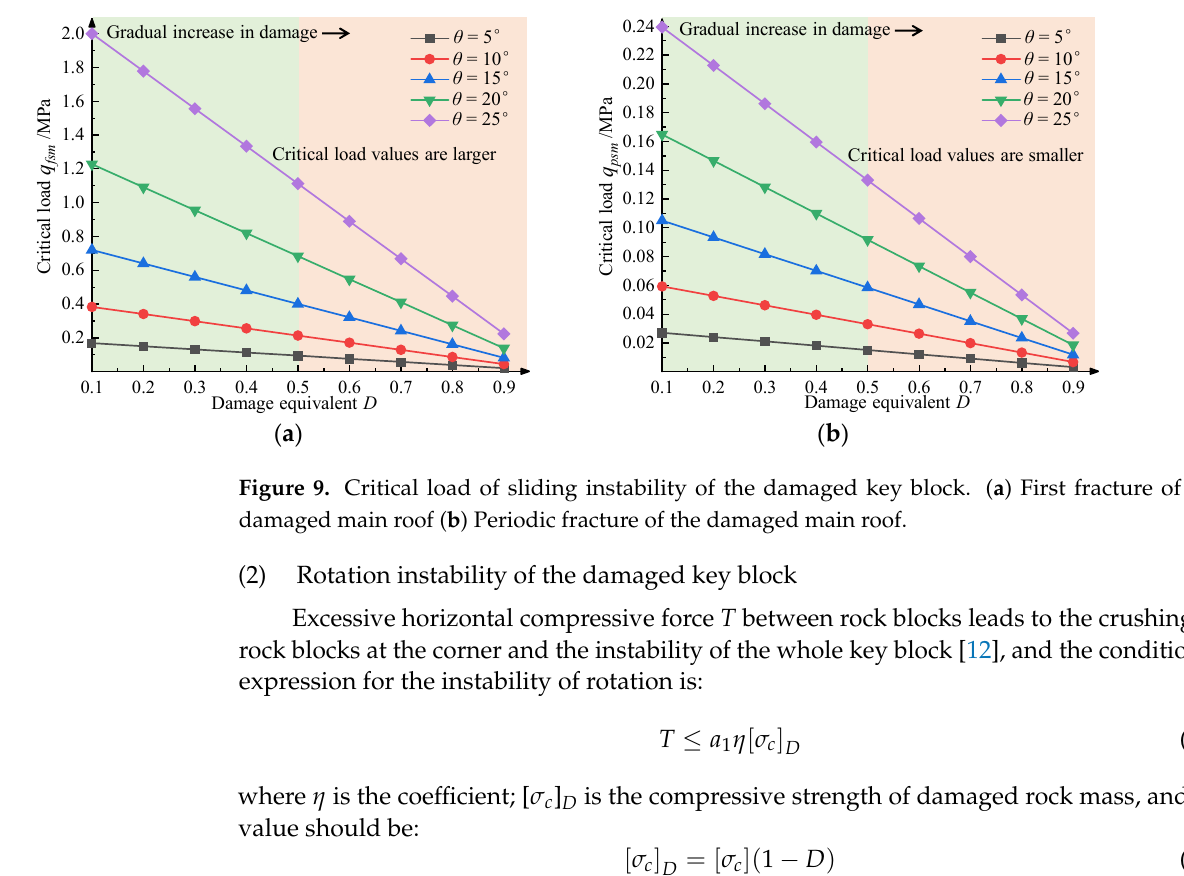
Figure 8. The critical lumpiness of sliding instability of the damaged key block. As shown in Figure 9, the critical load of key block sliding instability when the main i sm is substituted into Equations (11) and (13), respectively, and the relations between roof is broken for the first time is more significant than that of periodic fracture. Under critical loads q fsm , q psm and D (damage variable) in two states are obtained: the same rotation angle, the critical load of the first fracture is about 8.3 times that of the periodic fracture. In addition, the critical loads of both of them decrease with the increase in damage degree, and the reduction degree exceeds 80%.